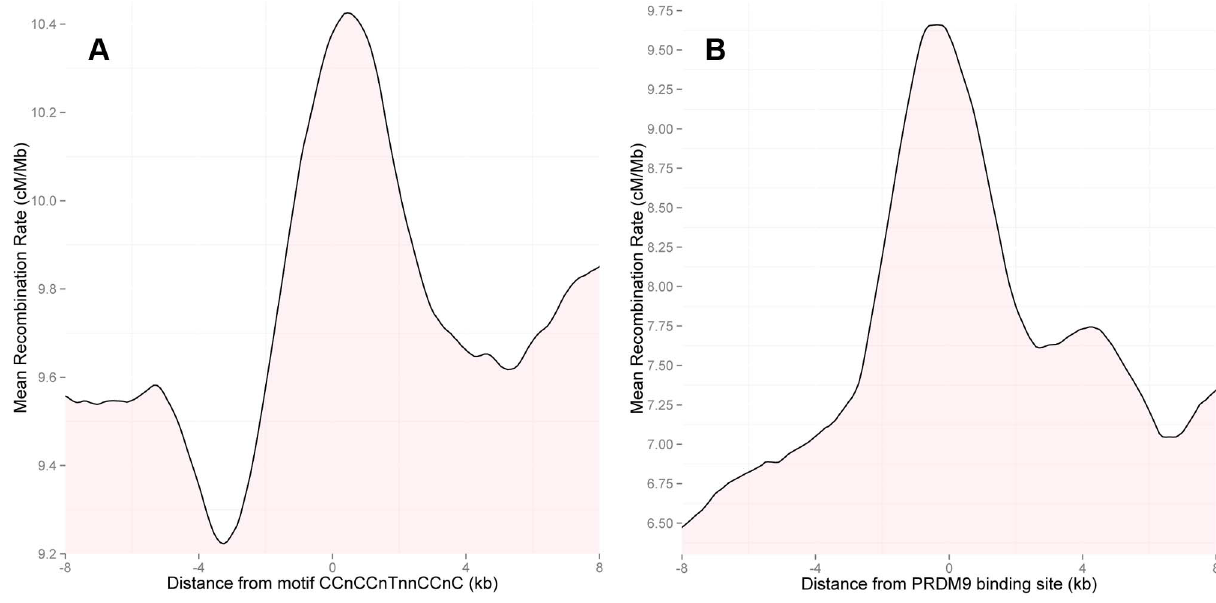
Figure 3. (A) Rate in the HapMap2 population-averaged LD-based map around instances of the 13-bp motif CCnCCnTnnCCnC in PAR1. Motifs in regions with an average SNP density of greater than one SNP per 2 kb in the surrounding 50 kb were included; clusters of motifs within 150 bp of one another were thinned to the most central motif. The plot shows 2 kb averaging, at 100 bp intervals. Motif positions show a strong local increase in recombination rate in the LD-based map. (B) As (A), but showing rates around ChIP-seq binding locations of the PRDM9 reference allele (B allele). In the event of more than one peak within 10 kb, only the most strongly signalled peak was included. ChIP-seq binding peaks of PRDM9 show a stronger rate increase in the LD-based map above local background rate than 13-bp motif sites.